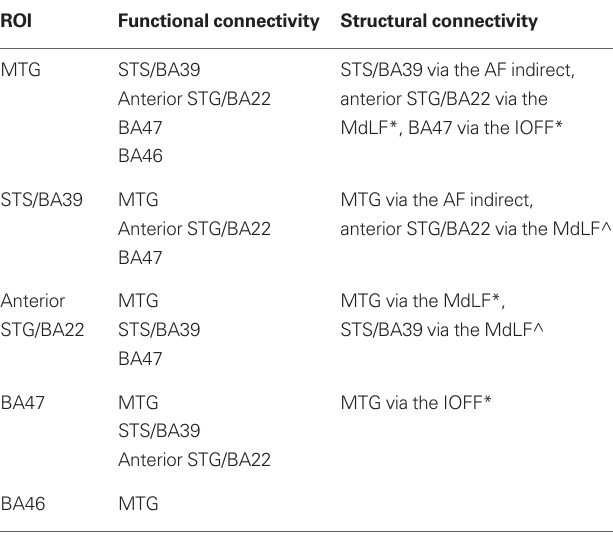
Table 2 | Summary of the structural and functional connectivity findings for each region of interest in relation to the other